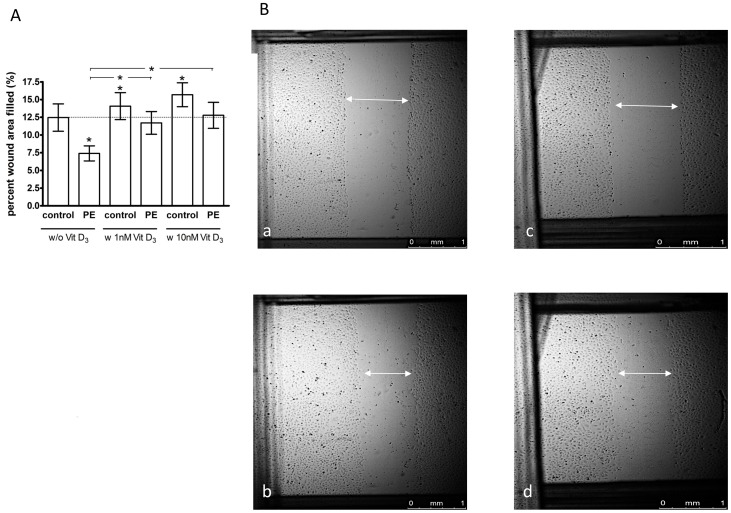
Effect of preeclampsia (PE) and 1,25(OH)2 vitamin D3 on ECFC migration.ECFCs of uncomplicated (control) and PE pregnancies were cultured in endothelial basal medium (EBM) +2% FBS and treated with or without 1 nM or 10 nM 1,25(OH)2 vitamin D3. A: The migration of ECFCs into the scratch wound was assessed after incubation for 8 h. Results represent mean ±SEM percent wound filling, n = 8. *P<0.05 vs. untreated control or (as indicated by horizontal lines above the vertical bars) vs. untreated PE. B: Representative images of ECFC monolayers with scratch wounds at 0 h (a, c) and 8 h (b, d) of incubation of control (a, b) and preeclamptic pregnancies (c, d).